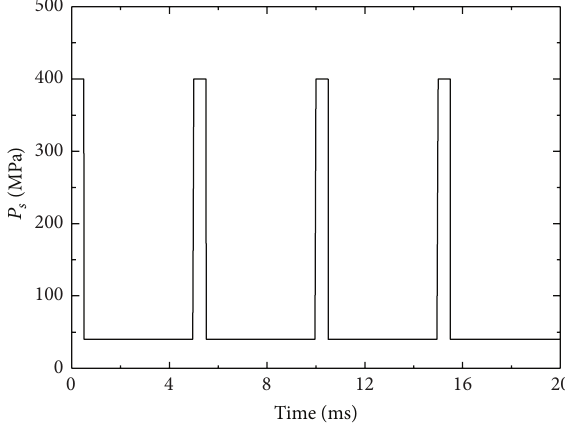
Figure 8: The loading history with four repeated